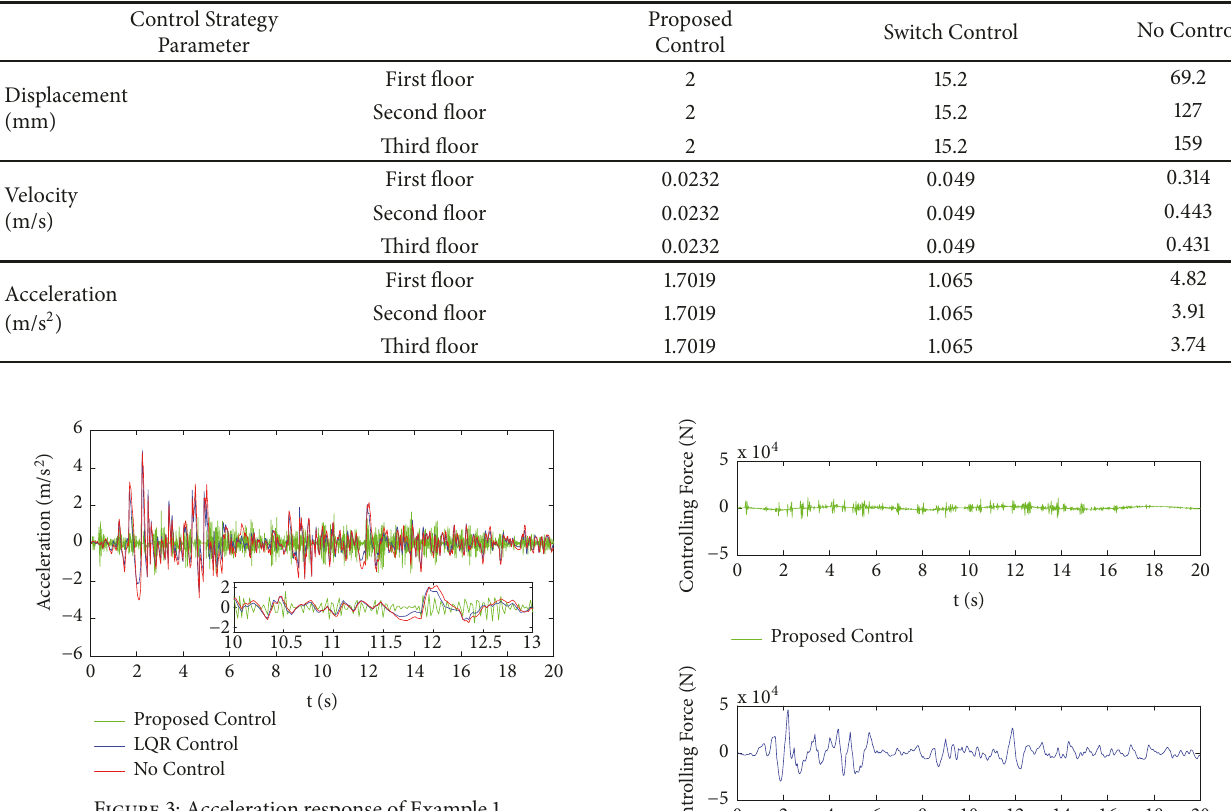
Figure 3: Acceleration response of Example 1.